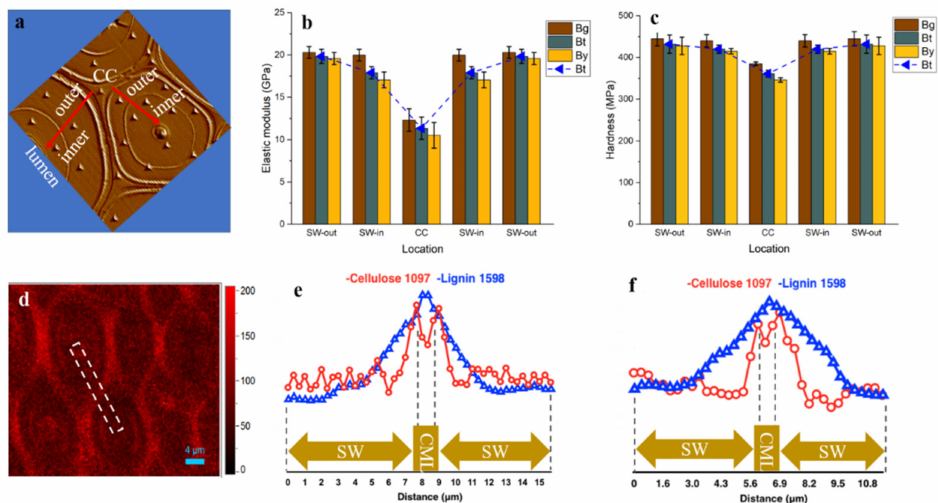
Figure 6. ( a ) The image obtained after indenting shows the actual position of indents; ( b,c ) The elastic modulus and hardness of bamboo fiber at different locations; ( d ) Raman image showing the cellulose microfibrils orientation distribution by integrating over 1097 cm − 1 ; ( e,f ) the Raman line scan of Bg ( e ) and Bt ( f ) fiber wall. The white dotted line indicates the typical region of the Raman spectra collected. SW-out: outer layer of fiber secondary wall; SW-in: inner layer of fiber secondary